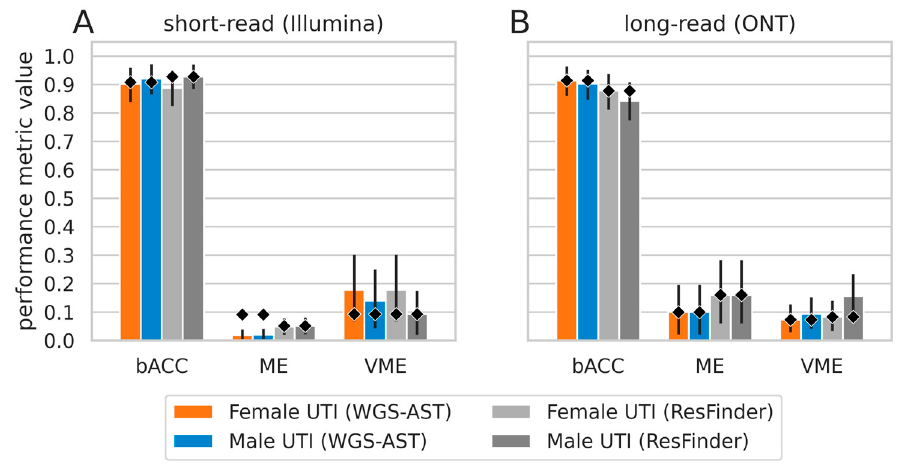
Figure 1. Performance metrics of MG-AST methods on simulated E. coli mono-infection complicated urinary tract infection (cUTI) metagenomes. The height of bars indicates the value taken on by balanced accuracy (bACC), major error (ME) and very major error (VME) in each investigated experimental setting. Metrics are aggregated over 5 antibiotic compounds. ( A ), performance on simulated short-read datasets. ( B ), performance on simulated Oxford Nanopore Technologies (ONT) sequencing datasets. Diamonds indicate baseline value taken on by the metric, obtained on isolate genome assemblies used to construct metagenomes. Error bars are 95% confidence intervals obtained by 1000 ×